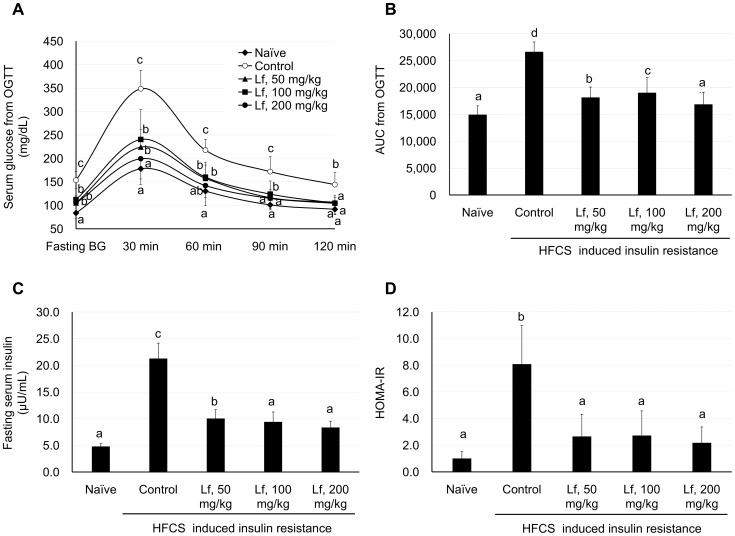
Insulin resistance and OGTT determination in HFCS-induced insulin resistance in the murine model.(A) Blood glucose determined by OGTT after oral administration of glucose (2%). (B) Area under curve (AUC) was calculated for the OGTT. The control group showed a significant increase compared to the naïve group, whereas lactoferrin at 50, 100, and 200 mg/kg markedly reduced the AUC. (C) Fasting serum insulin was determined by ELISA. Insulin levels were significantly increased in the control group compared to the naïve group, and lactoferrin at 50, 100, and 200 mg/kg markedly reduced blood insulin. (D) HOMA-IR insulin resistance calculated from fasting serum glucose and insulin levels. Lactoferrin at 50, 100, and 200 mg/kg markedly reduced blood insulin. Data are presented as mean ± SD (n = 10) and were analyzed using one-way ANOVAs and Duncan's multiple range test. a–d: Different letters indicate significant differences between groups (P<0.05).